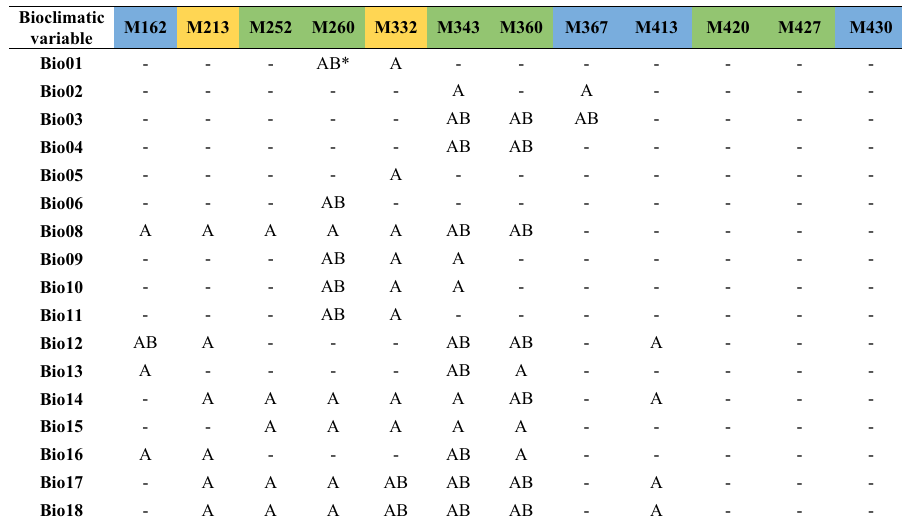
Table 3. Potential F ST outlier markers identified by both Mcheza and BayeScan (in green), exclusively by Mcheza (in blue), and exclusively by BayeScan (in yellow), along with their Association with bioclimatic variables detected using Samβada and LFMM. * A represents significant correlation of outlier loci (either identified by Mcheza or Bayescan) and bioclimatic variables as revealed by Samβada; B represents significant correlation of outlier loci (either identified by Mcheza or Bayescan) and bioclimatic variables as revealed by LFMM.